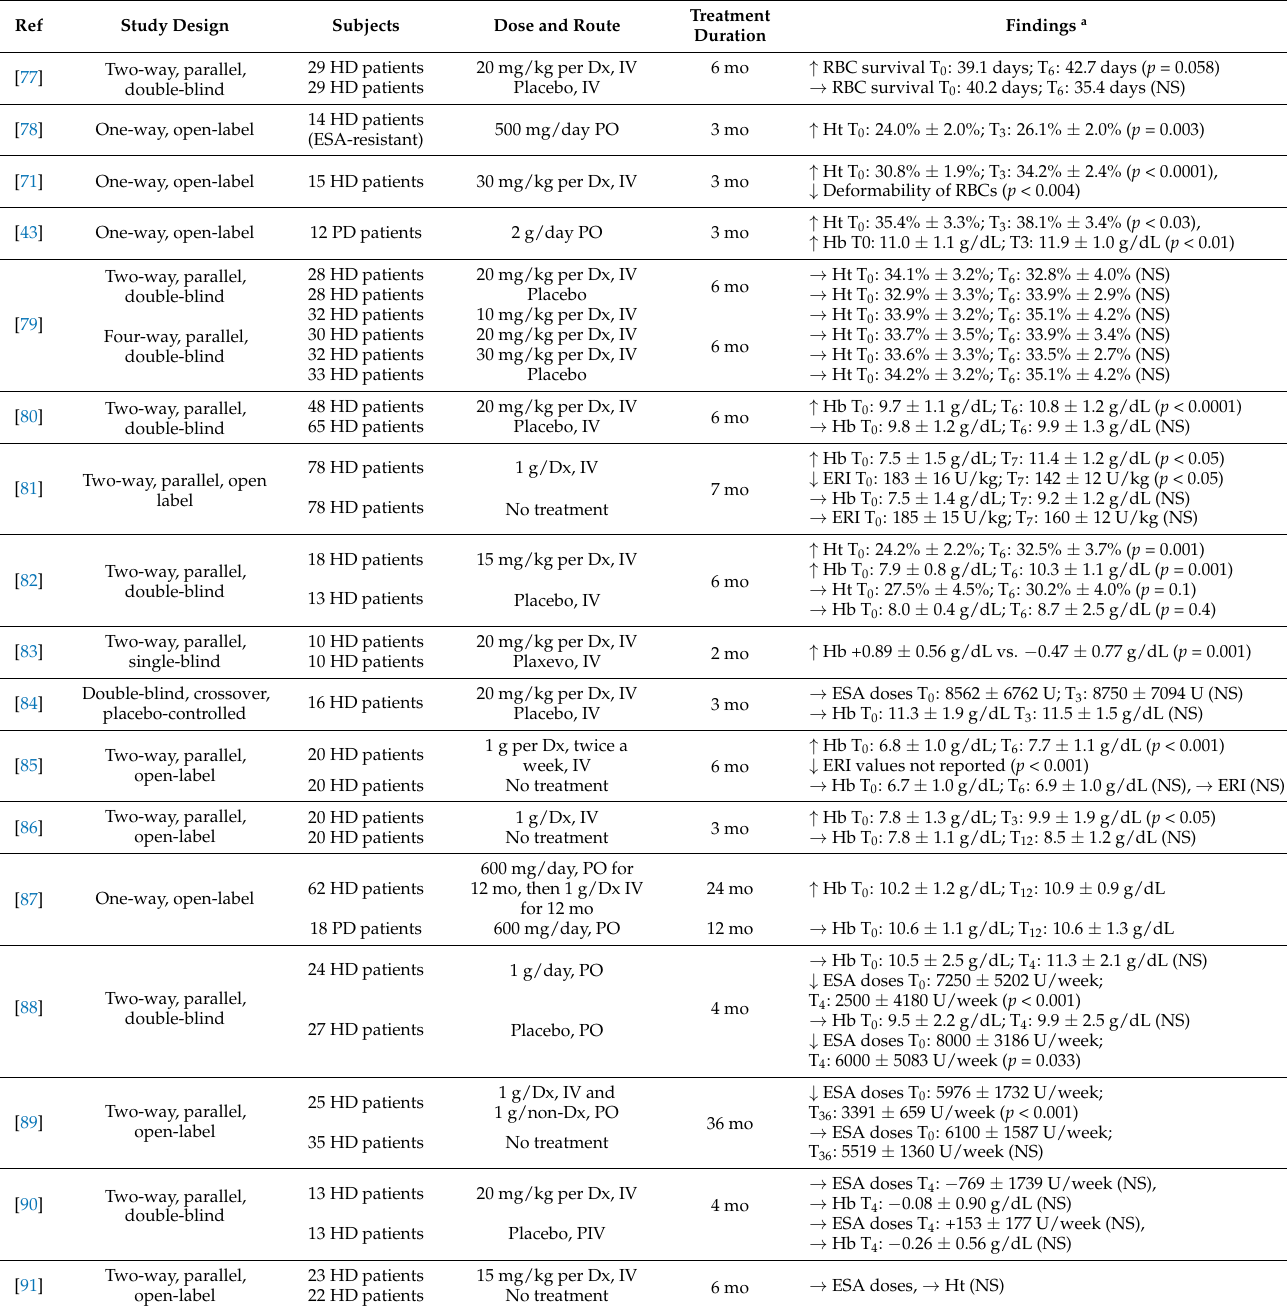
Table 1. Studies of the effects of levocarnitine on renal anemia in dialysis